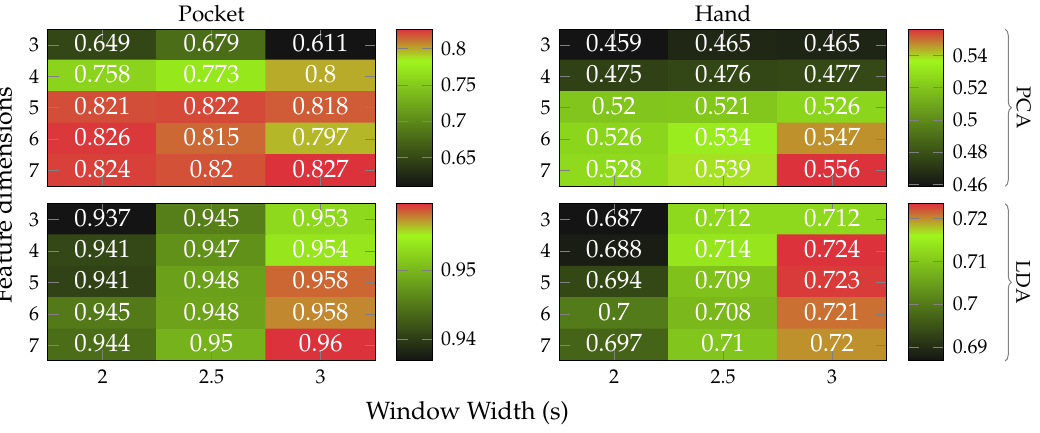
Figure 24. Classification accuracies achieved for different window widths and remaining dimensions after the analytical transformation on the concatenated feature vector. The benchmark was done for both pocket-case and hand-case, comparing the use of both PCA and LDA.